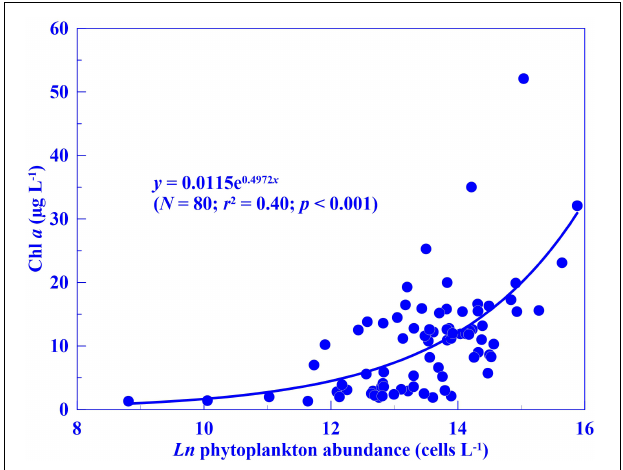
FIGURE 3 | Correlation analysis between seasonal chlorophyll a (Chl a ) concentration and phytoplankton abundance in Dapeng Bay